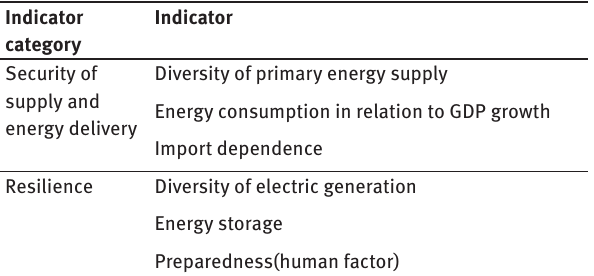
Table 1: Indicators used to calculate energy security’s grade levels in the World Energy Trilemma Index,